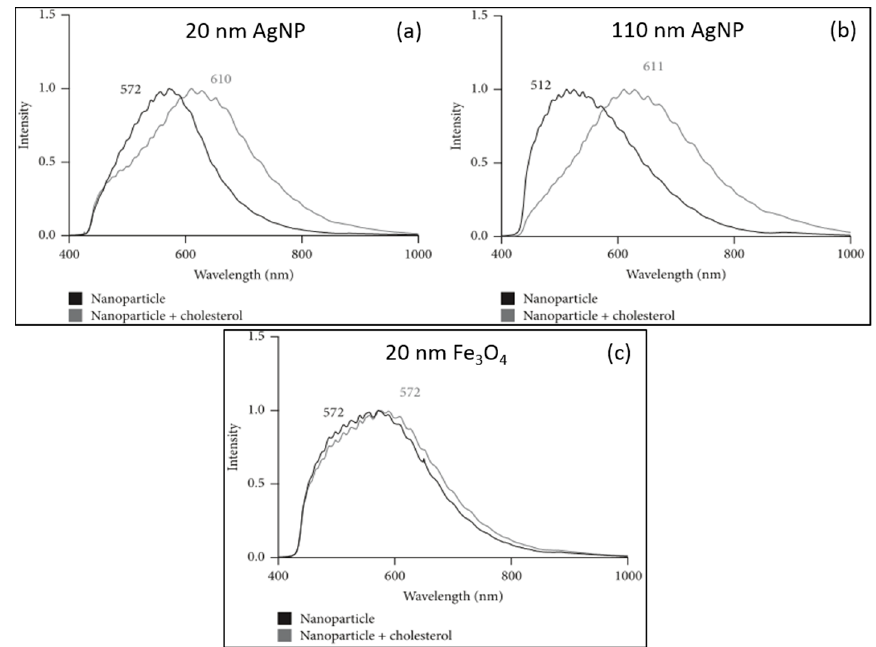
Figure 8. Impact of cholesterol on the optical properties of silver and iron oxide NPs ( a ) a 38 nm redshift is visible upon interaction of the 20 nm AgNP with cholesterol ; ( b ) a 99 nm redshift is visible, resulting from cholesterol interaction with the of 110 nm AgNP; ( c ) only spectral broadening can be observed for the 20 nm IONPs maintaining the spectral maximum at 572 nm [20].